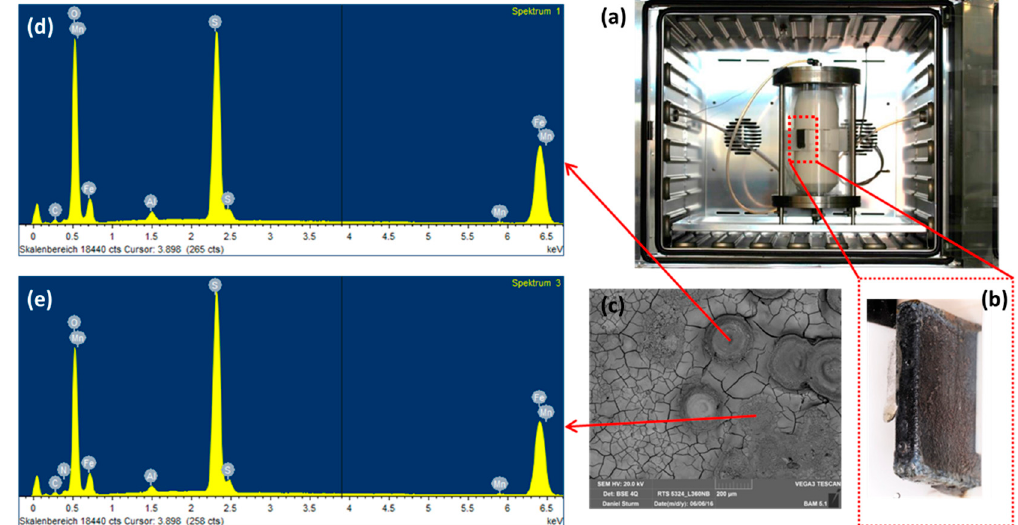
Figure 6. Gaseous reactor ( a ) with the L360NB coupon attached on the Teflon case ( b ) and the ( c ) SEM and ( d , e ) EDS spectra of the coupon after 7 days exposing to CO 2 gas with 6 times reduced NO 2 , SO 2 , and O 2 and same H 2 O concentration.